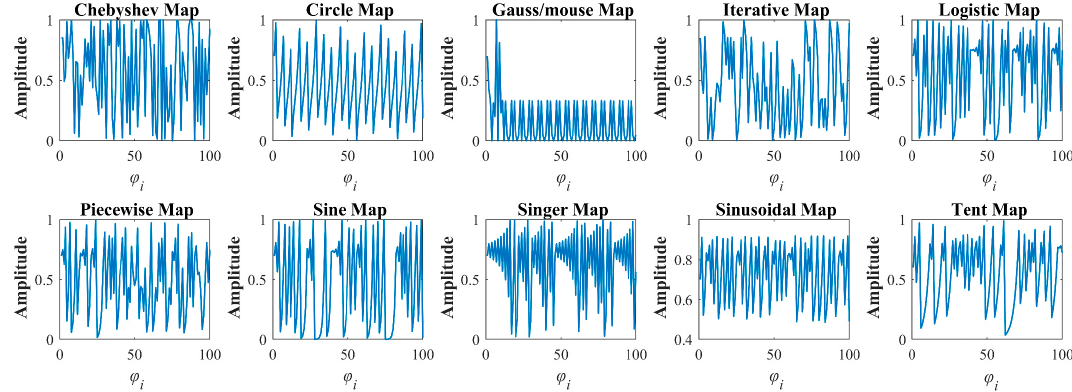
Figure 5. Visualization of ten commonly used chaotic maps. Table 2. Ten chaotic maps.